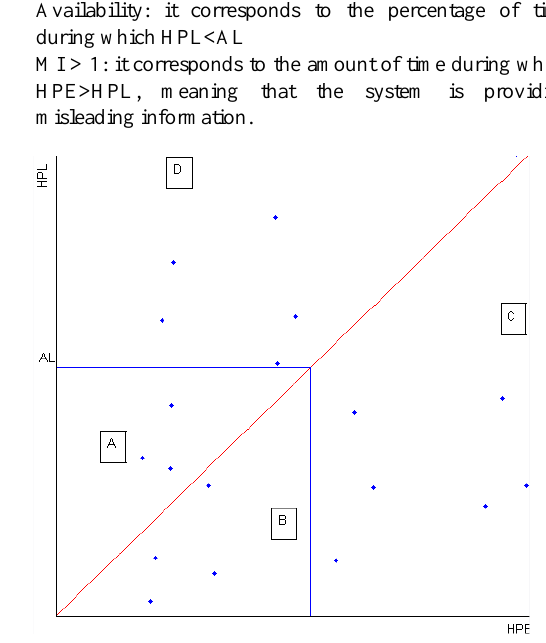
Figure 1. Integrity correlation (HPE and HPL correlation)